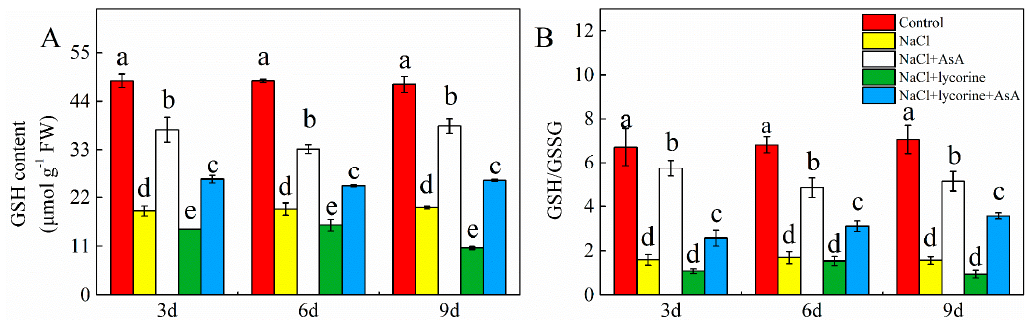
Figure 8. Values of reduced glutathione (GSH) content ( A ) and the ratio of GSH/GSSG (reduced glutathione/oxidized glutathione) ( B ) in leaves of salt-stressed tomato seedlings with or without exogenous reduced ascorbic acid (AsA) and lycorine (AsA synthesis inhibitor) spraying. Abbreviations 3d, 6d, and 9d represent the third, sixth, and ninth day after treatment, respectively. Control, no added